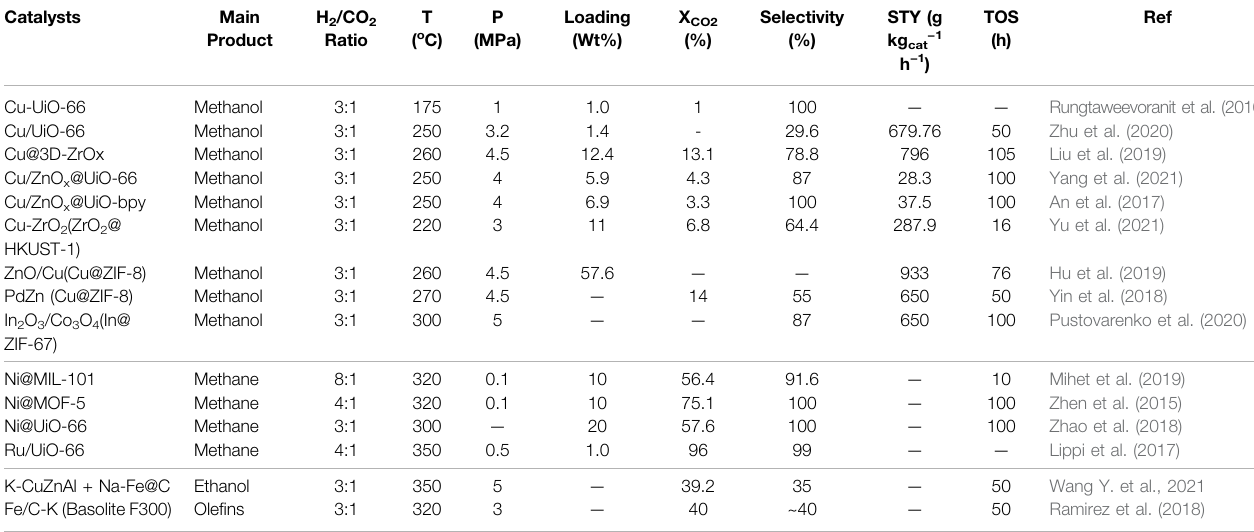
TABLE 1 | Summary performance of catalysts for CO 2 hydrogenation reaction. Catalysts Main